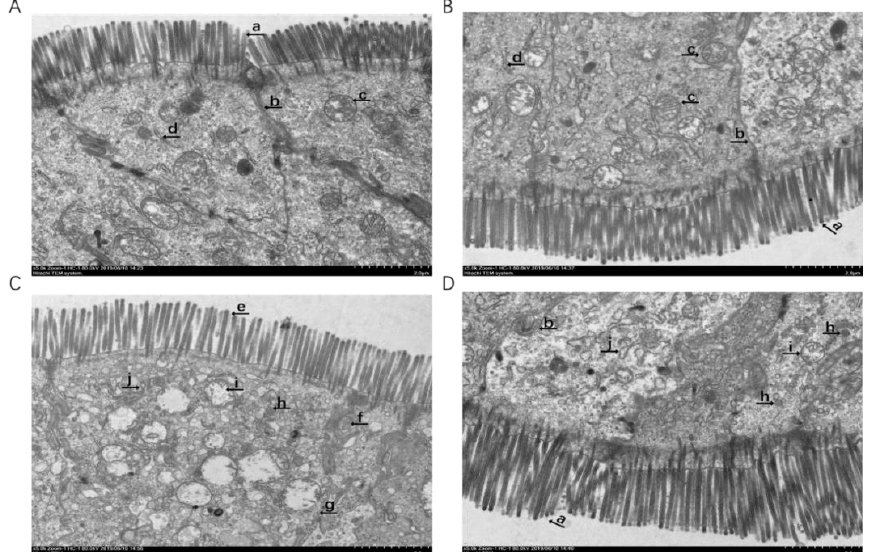
Figure 3. The epithelial cells ultrastructure in the jejunum of the piglets fed polyphenols sourced from Ilex latifolia Thunb. (PIT) diets under oxidative stress. Representative ultrastructure is shown. These pictures were obtained by transmission electron microscopy. ( A ) Piglets fed the basal diet and treated with saline. ( B ) Piglets fed the PIT diet and treated with saline. ( A , B ) There are no obvious ferroptosis characteristics. Presented as the closely arranged microvilli (a), normal tight junction (b), mitochondria with distinct cristae (c), normal rough endoplasmic reticulum (d). ( C ) Piglets fed the same basal diet and treated with diquat. Significant ferroptosis characteristics were observed, such as the sparsely arranged microvilli (e), indistinct tight junction (f), disconnected tight junction (g), mitochondrial pyknosis (h), mitochondrial cristae reduction (i) and dilatations of rough endoplas- mic reticulum (j) were found. ( D ) Piglets fed the same PIT diet and treated with diquat. Original magnifications 5000×. Scale bars = 2 μm. 3.6. Intestinal Mucosal Gene Expressions of the Key Genes Related to Ferroptosis There were significant interactions between diet and stress on gene expressions of jejunal TFR1, SLC7A11 and GPX4 ( p < 0.05, Table 7). Supplementation with PIT signifi- cantly reduced jejunal TFR1 gene expressions and improved SLC7A11 and GPX4 gene expressions in the piglets under oxidative stress ( p < 0.05). Meanwhile, significant interac- tions between diet and stress on gene expressions of ileal TFR1, HSPB1 and GPX4 were observed ( p < 0.05). Supplementation with PIT significantly reduced ileal TFR1 and HSPB1 gene expressions and improved GPX4 gene expressions in the piglets under oxidative